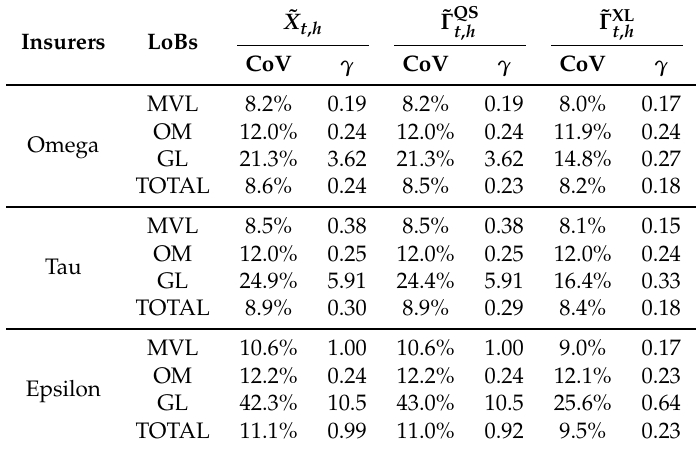
Table 7. CoV and Skewness of simulated distribution for each LoB (Motor oriented Portfolio Mix).